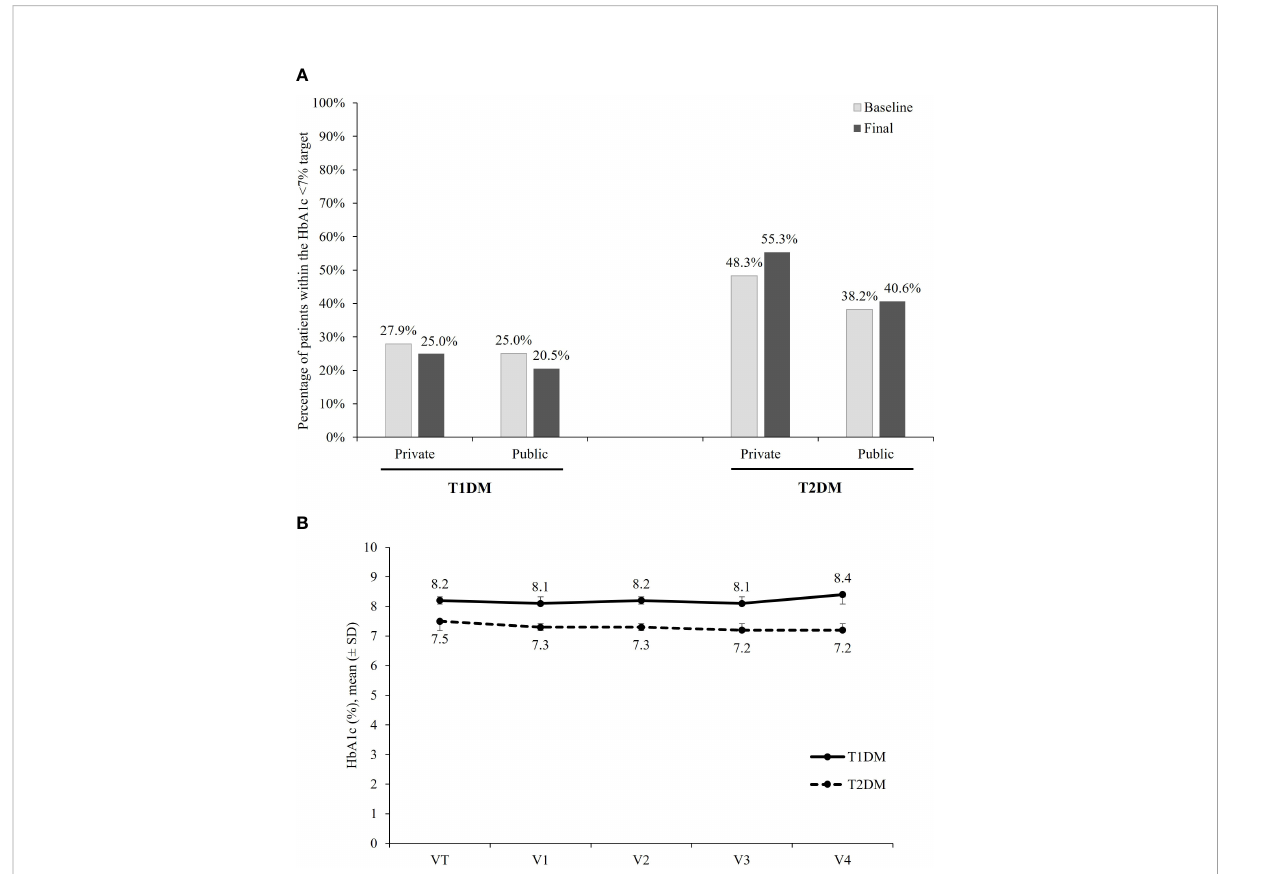
FIGURE 1 HbA1c. (A) Percentage of patients achieving the target of HbA1c <7%, according to the DM type and health care sector. (B) Mean ( ± SD) HbA1c (%) per visit, according to the DM type.